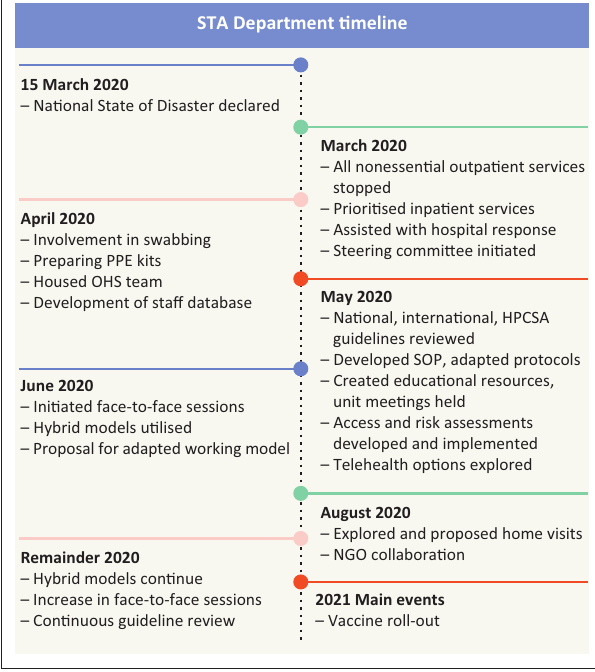
FIGURE 2: STA Department